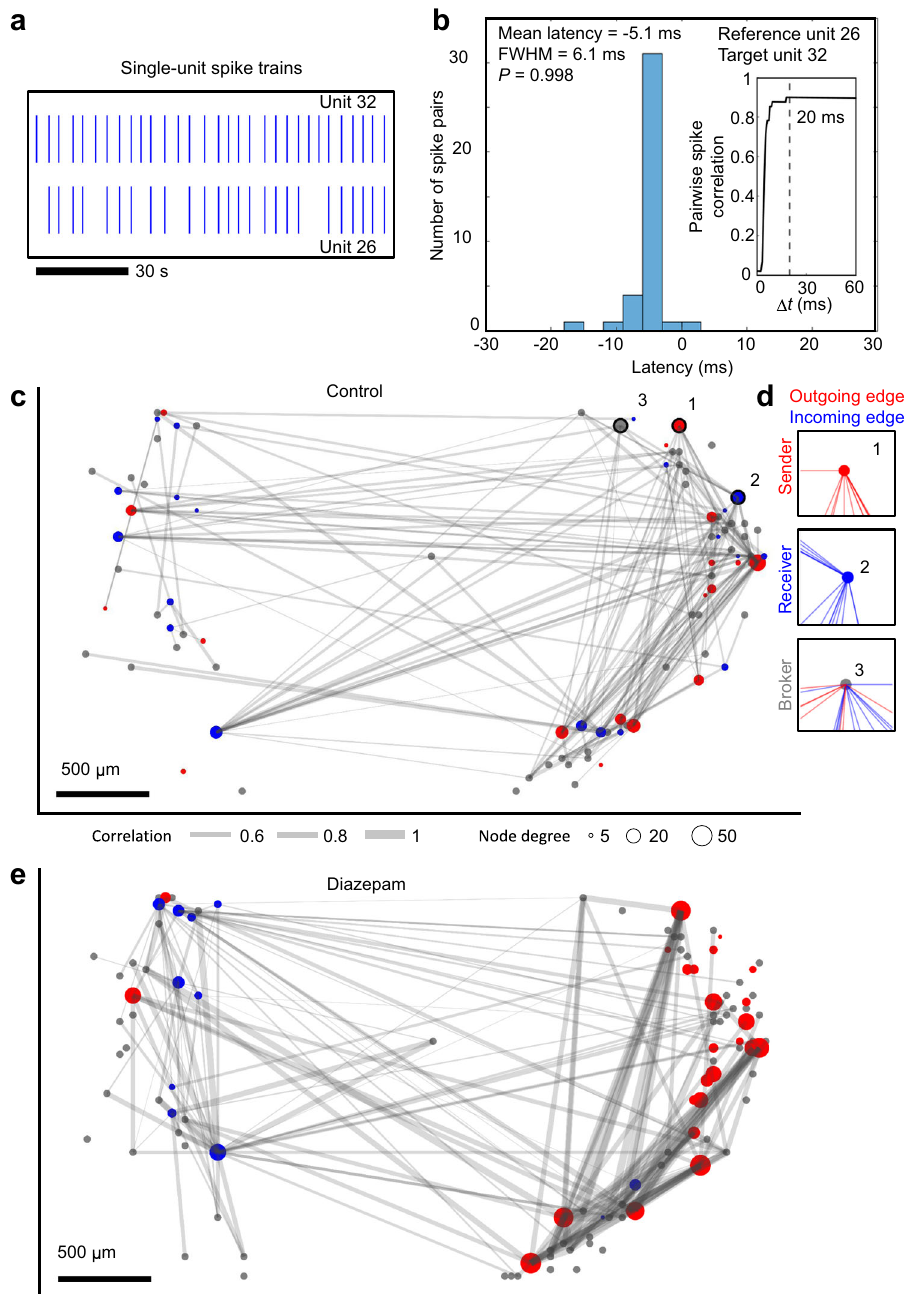
Fig. 5 | Mapping information fl ow through a human brain organoid slice. a Extracellular action potential spike events are shown from two correlated spike- sortedunits. b Thespiketimelatencydistributionisshownbetweenthetwospike- sorted units shown in a . The latency distribution between pairwise spike events is unimodal (Hartigans ’ dip test for multimodality, p =0.998), with a mean latencyof 5.1ms and a FWHM of 6.1ms. The inset shows the pairwise spike correlation was calculated using the spike time tile coef fi cient (STTC) as a function of correlation time window ( Δ t ) for the two correlated spike-sorted units shown in a . Choosing a correlation time window Δ t =20ms captures all pairwise spike interactions between the two units. c Functional connectivity map showing the pairwise cor- relation strength (edge thickness in gray) between spike trains. Sorted by